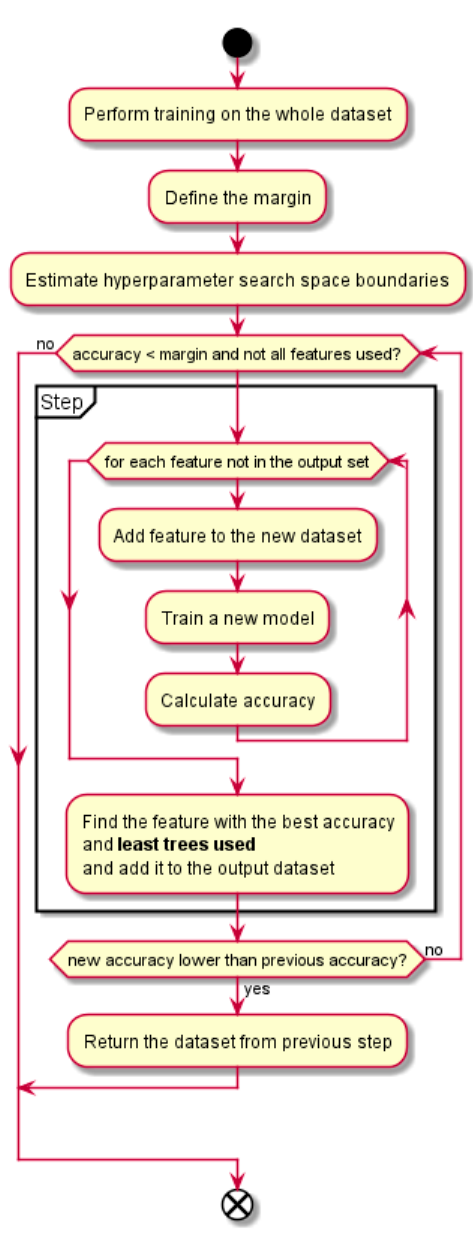
Figure 1. Block diagram of the new proposed algorithm.